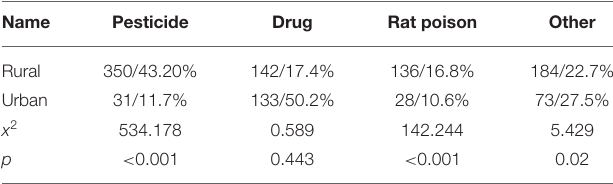
TABLE 3 | Distribution of poisonous substances in urban and rural areas